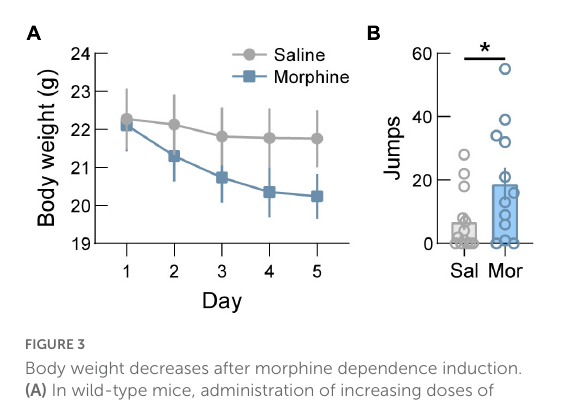
FIGURE3 Body weight decreases after morphine dependence induction. (A) In wild-type mice, administration of increasing doses of morphine (20/40/60/80/100 mg/kg, s.c.) to induce dependence drives significant weight loss. (B) Jumping behavior, a symptomatic indicator of spontaneous withdrawal, is increased following induction of opioid dependence in saline (Sal) versus morphine (Mor) treated mice. See Supplementary Table 1 for details on statistical analyses. * p < 0.05.